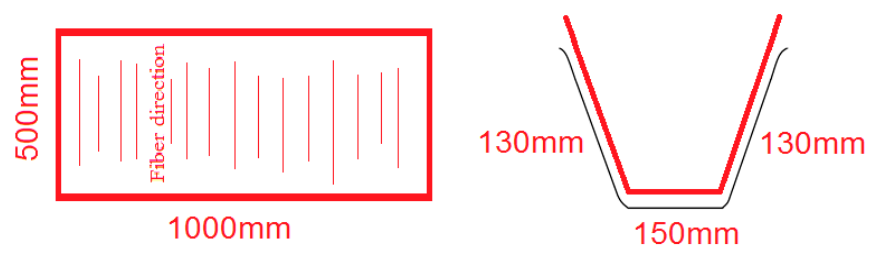
Figure 4. A schematic of bamboo-fiber placement into U-shaped molds for stirrup manufacture.